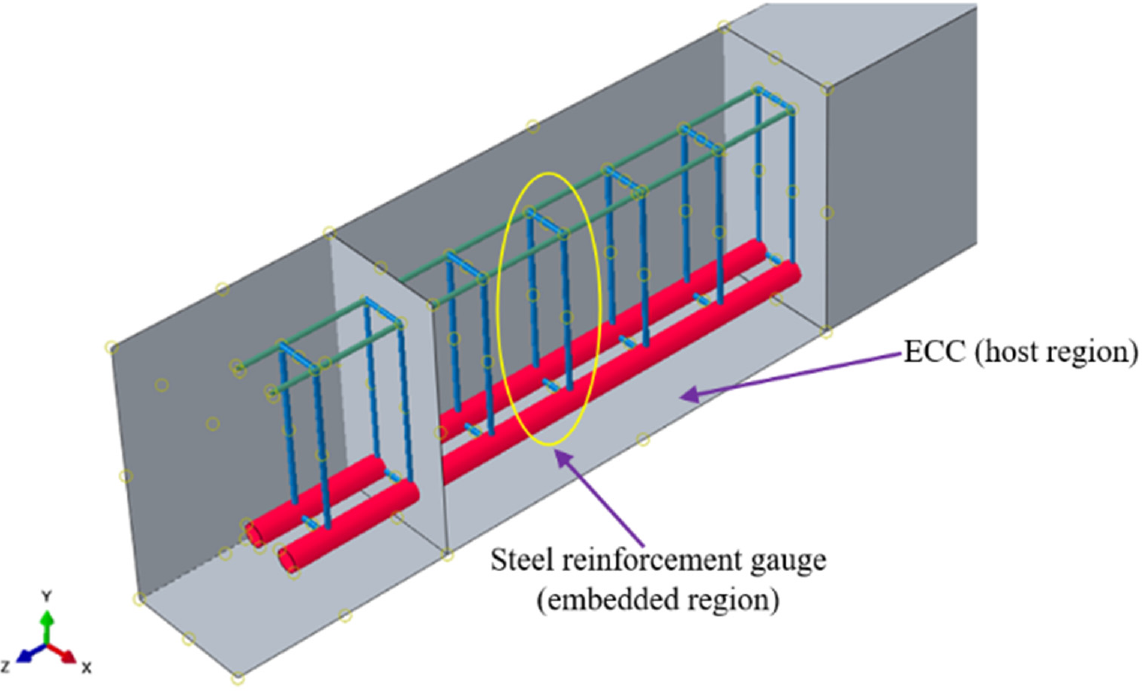
Figure 5. Embedded constraints used in FE Model.